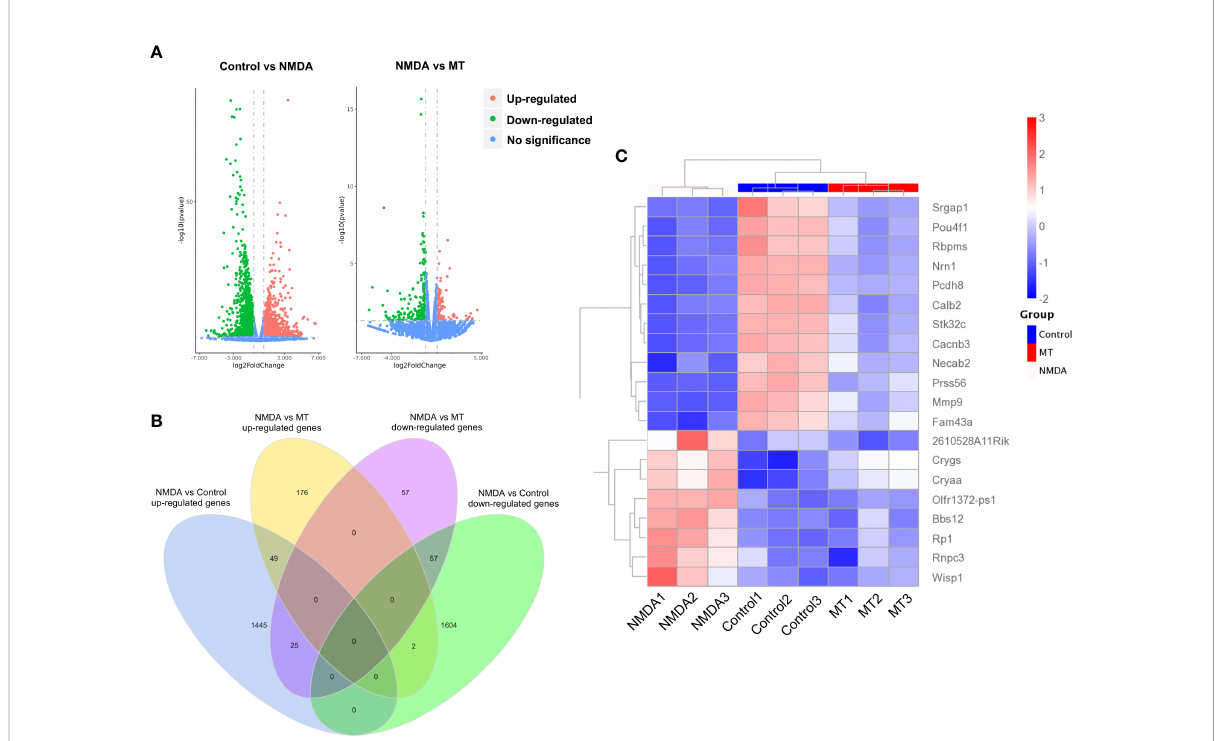
FIGURE 5 MT ameliorates retinal transcriptome abnormalities in NMDA-induced retinal injury. (A) Volcano plot of differentially expressed genes between control, NMDA, and MT groups. (B) Venn diagram shows the differentially expressed genes among the control, NMDA, and MT group. (C) The heat map shows MT-restored top 20